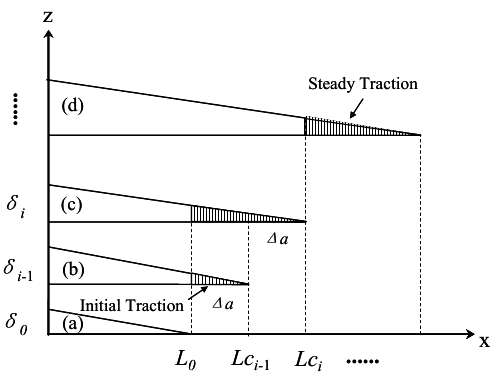
Figure 1. Diagram for CNT bridging and traction stages.